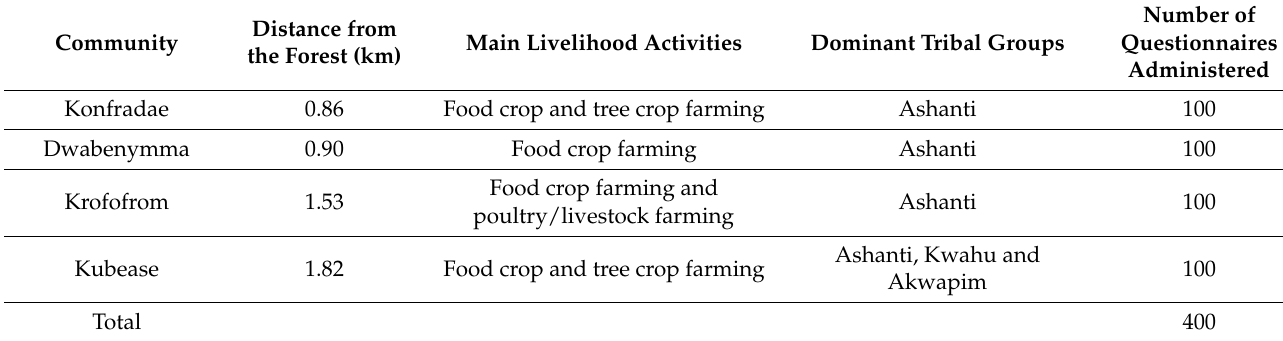
Table 1. Community, distance from the forest and number of questionnaires administered.